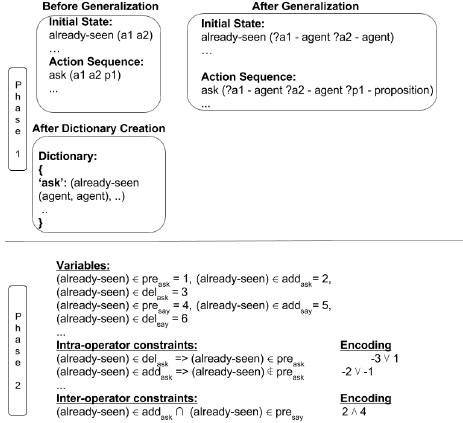
Figure 2: Illustration of Phases 1 and 2 of our approach. In Phase 1, the dialog corpus is annotated with pre-engineered speech acts to produce a representation closer to AP. The new representation is then used to formulate intra and inter-operator constraints in the second